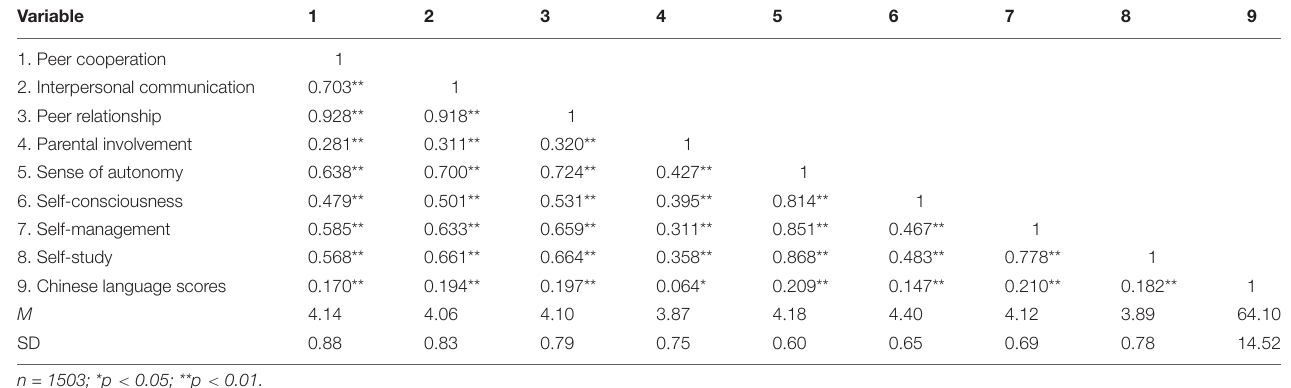
TABLE 1 | Descriptive statistics results and correlation matrix.